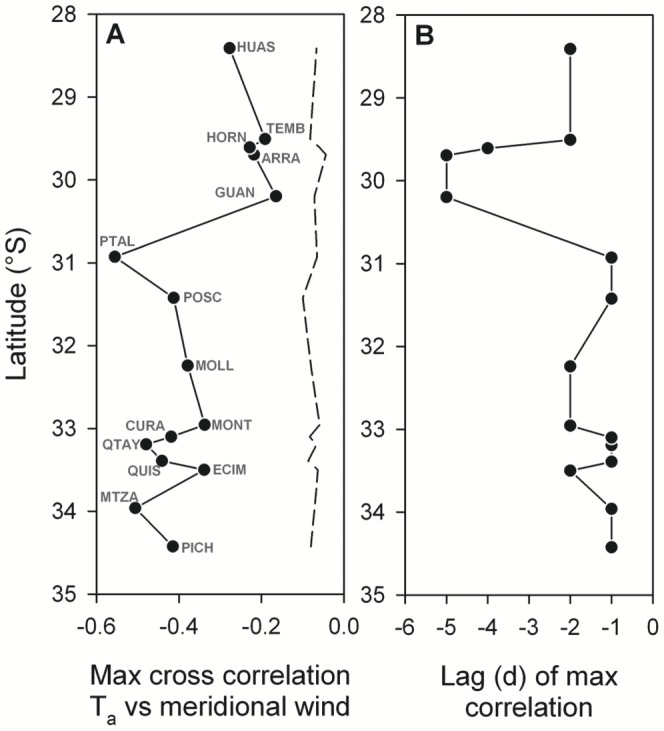
Latitudinal pattern in thermal response to wind variability.(A) Maximum cross-correlation between daily in situ temperature anomalies and alongshore wind stress, (B) time lag (days) corresponding to the maximum cross-correlation. Dashed line in (A) indicates the 95% significance limit for each site-specific correlation.